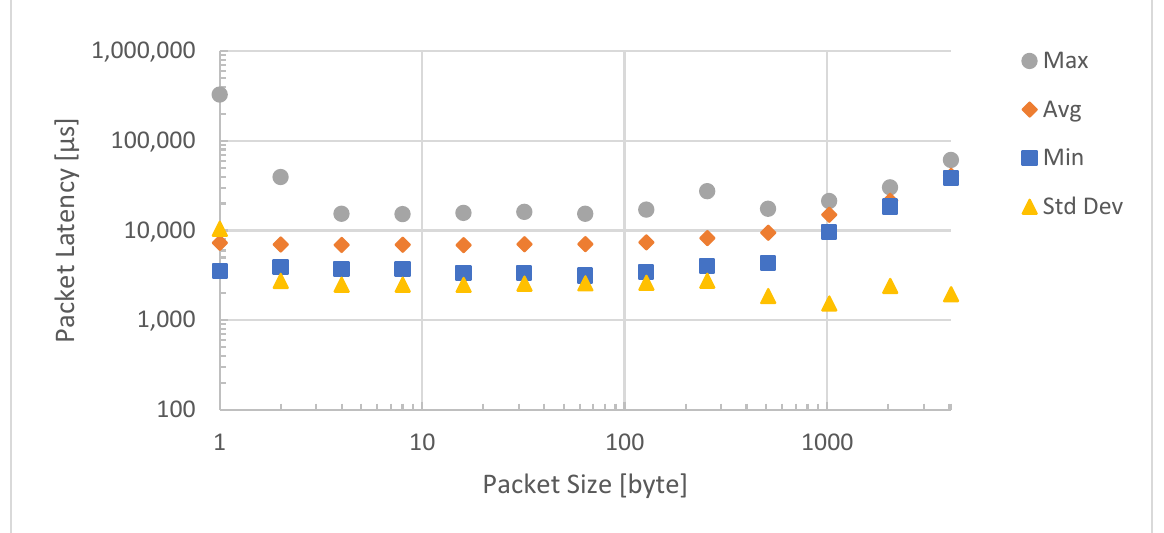
Figure 9. Packet latency for a bridged connection over WIU gateway to WIU node.